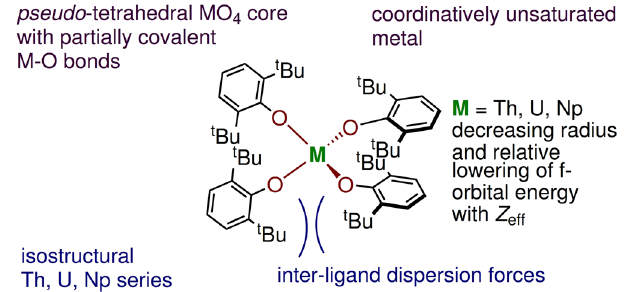
Fig. 1 | Pseudo tetrahedral actinide molecules investigated in this study. Che- mical structure of tetra-coordinated early actinide aryloxides M(OAr) 4 (M=Th, U, Np; OAr=2,6-di- tert -butylphenoxide).